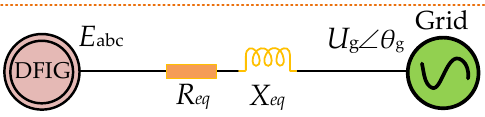
Figure 3. Equivalent circuit diagram for the DFIG ‐ IFLVSG grid ‐ connected system.